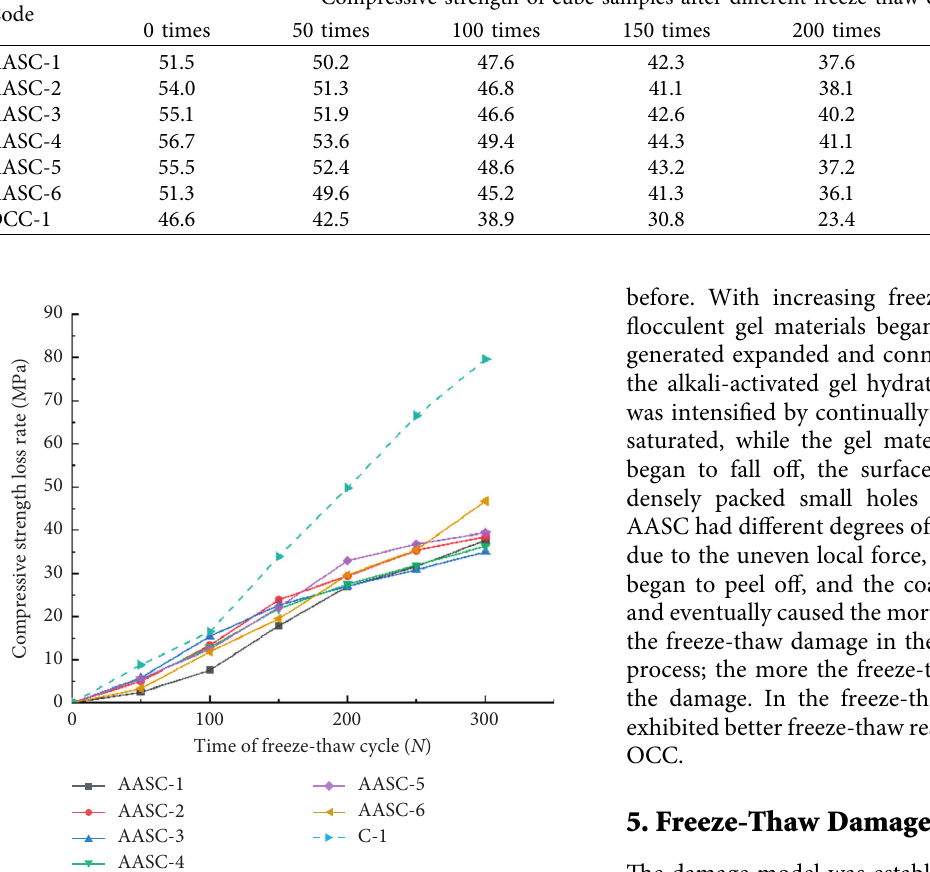
Table 6: Compressive strength of cube samples after different freeze-thaw cycles. Code